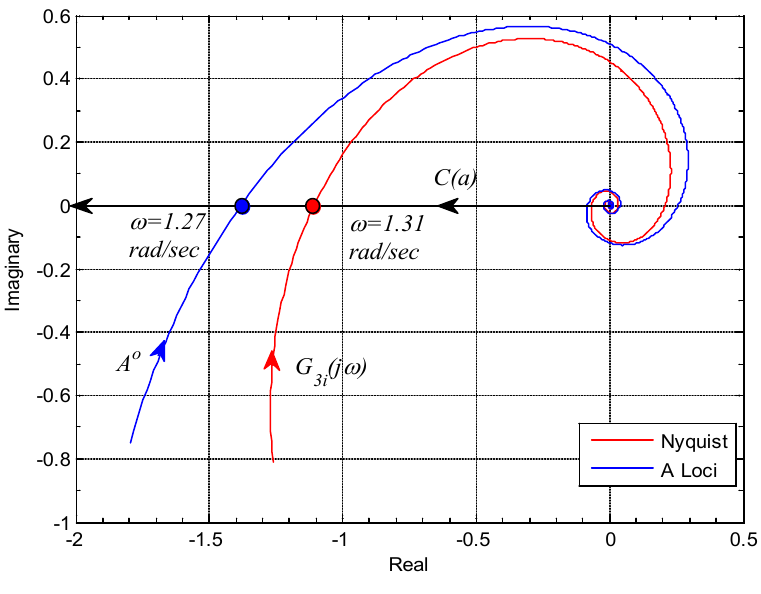
Figure 16. A Loci and Nyquist diagram